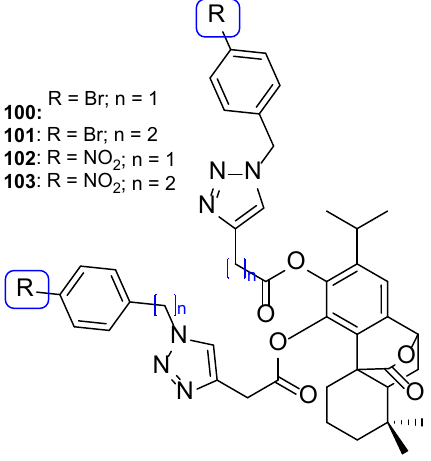
Figure 48. Chemical structures of compounds 98 and 99 , and SAR [133].